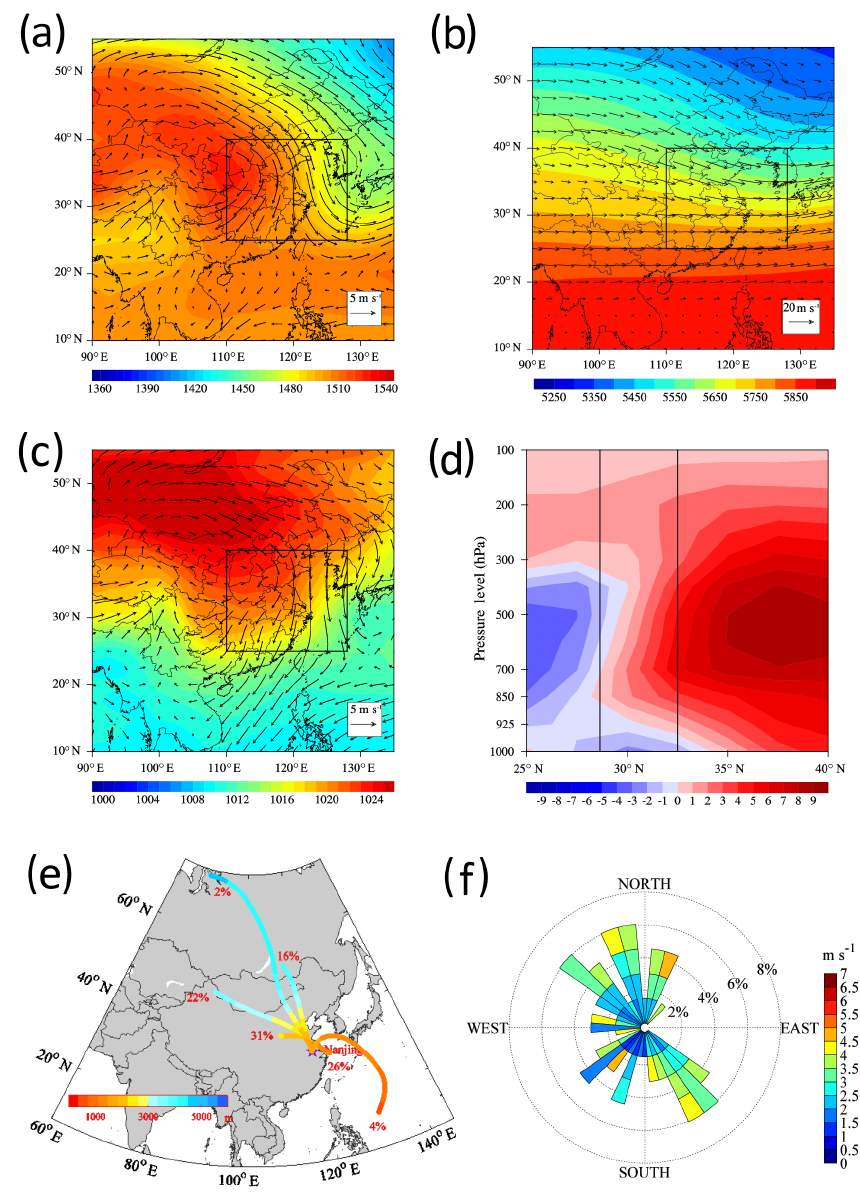
Figure 9. As in Fig. 7, but for Pattern